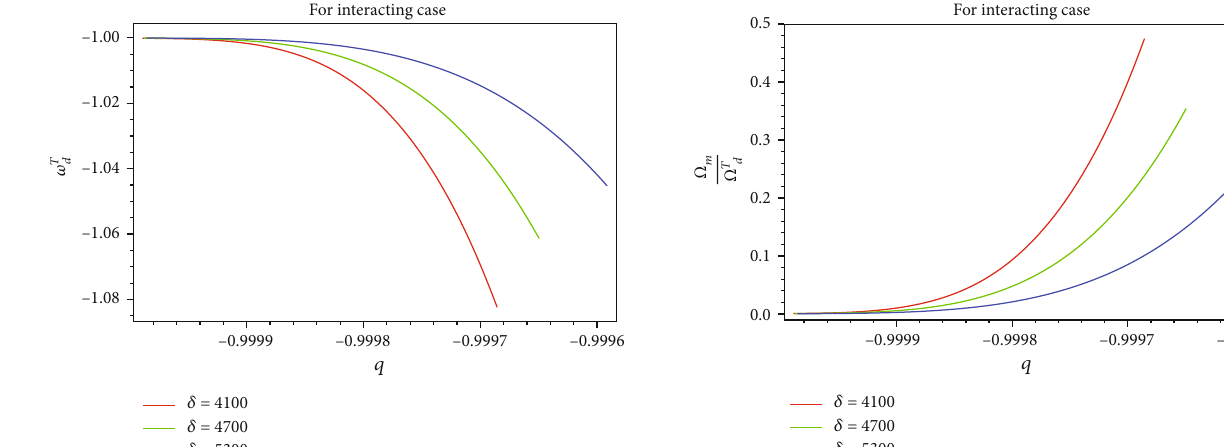
versus deceleration parameter q . d